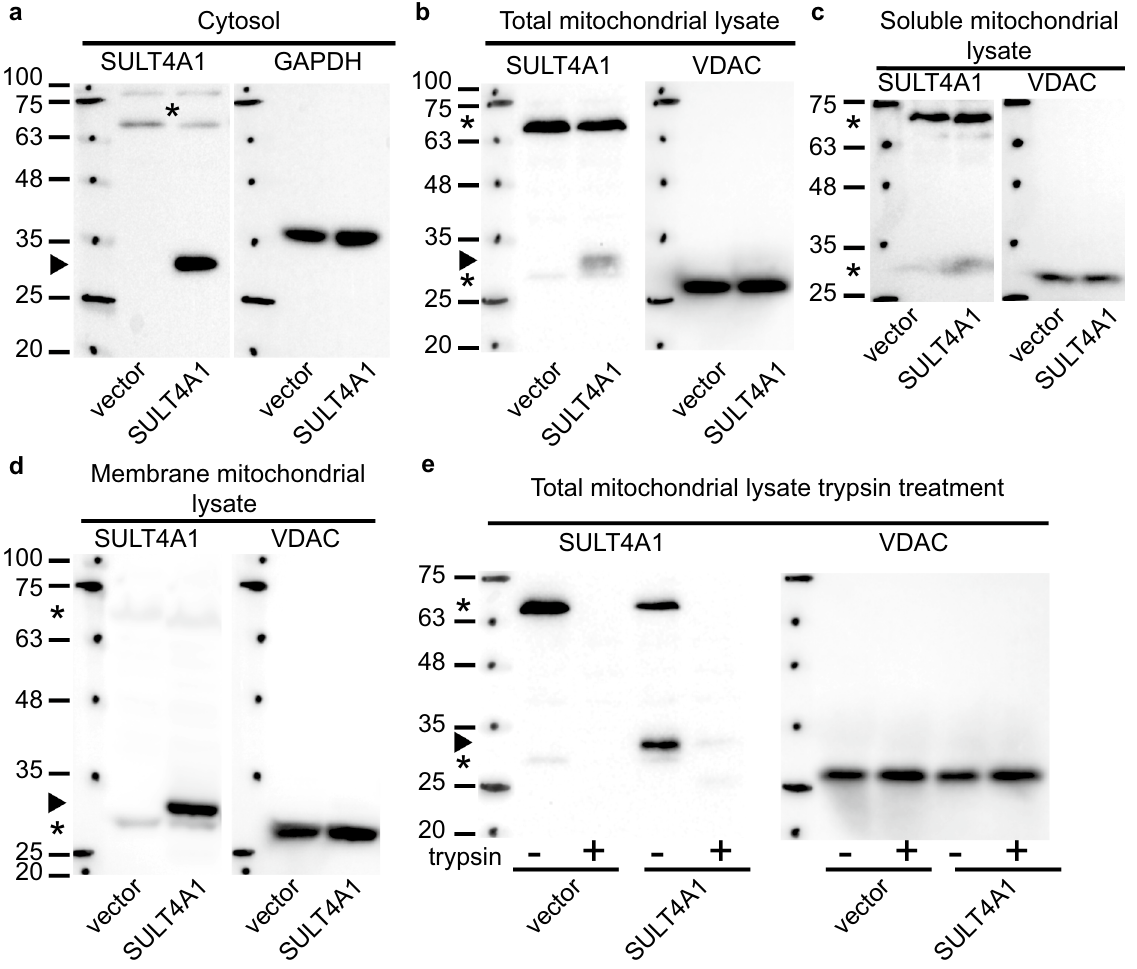
Figure 2. SULT4A1 subcellular distribution in yeast. Yeast transformed with YCpGAL1 SULT4A1 •L (SULT4A1) or control (vector) were exponentially grown in galactose for 36 h. Spheroplasts were generated and subcellular fractions isolated via differential centrifugation and sucrose gradient resolution of spheroplasts lysates. 20 μg of protein of each were resolved via SDS-PAGE and transferred to a PVDF membrane followed by immunostaining for SULT4A1 followed by stripping and immunostaining for loading control proteins; GAPDH-cytosol; VDAC1-mitochondria. ( a ) cytosol; ( b ) total mitochondrial lysate; ( c ) purified mitochondrial soluble lysate and ( d ) insoluble mitochondrial membrane fraction; ( e ) total lysates of purified mitochondrial fraction with ( +) or without (-) trypsin treatment. Arrowhead points at SULT4A1, *: non-specific staining of anti-SULT4A1 antibody. Protein ladder with sizes in